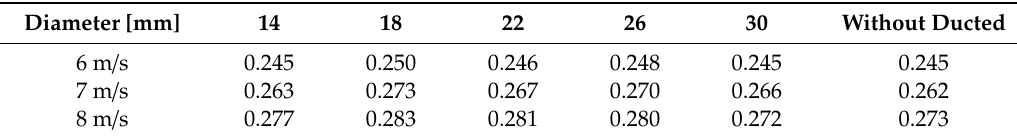
Table 3. Power coe ffi cient values depending on duct diameter for airspeed values 6, 7, and 8 m / s on the 6-ducted blade with the 7 ◦ angle of attack and 35 ◦ duct Table 3. Power coefficient values depending on duct diameter for airspeed values 6, 7, and 8 m/s on the 6-ducted blade with the 7° angle of attack and 35° duct slope.